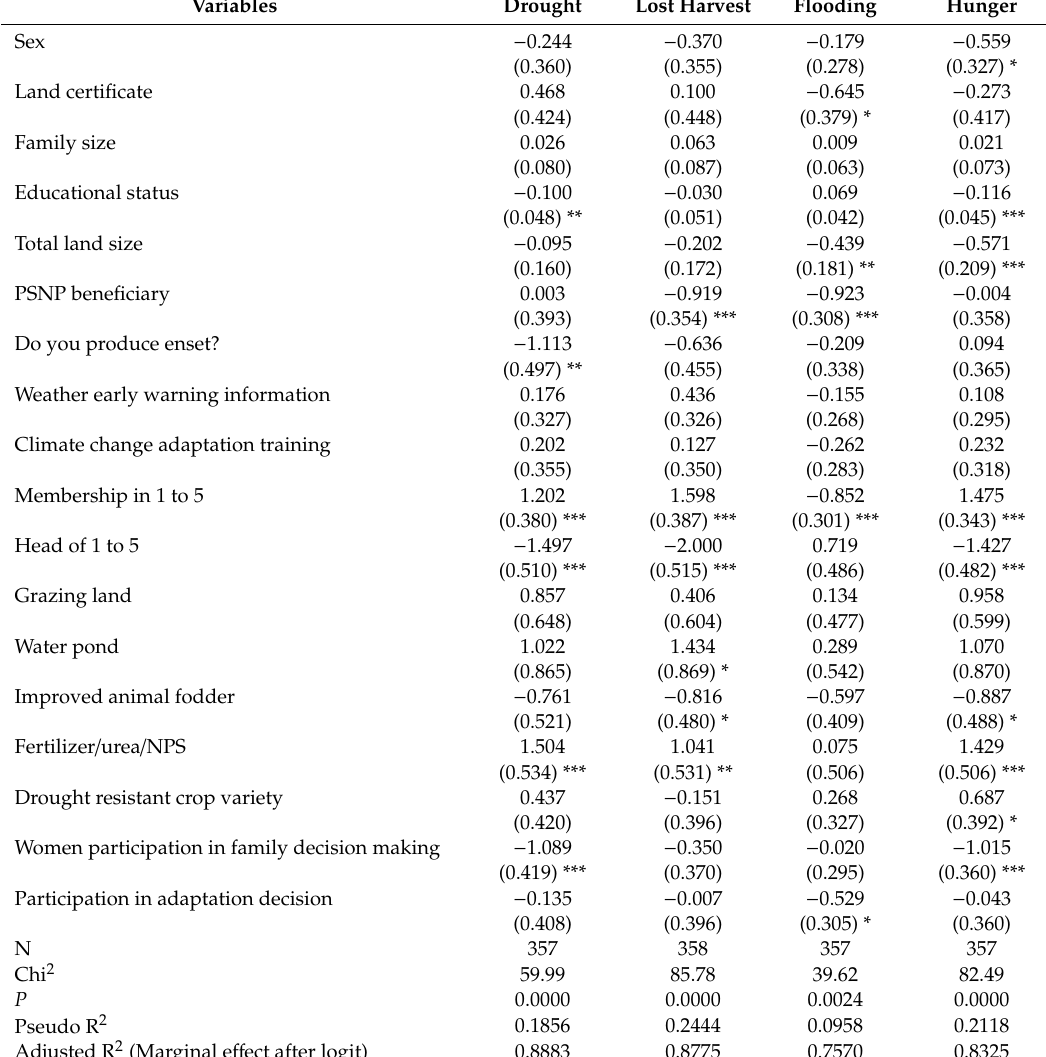
Table 5. Marginal e ff ects due to independent variables (the coe ffi cients